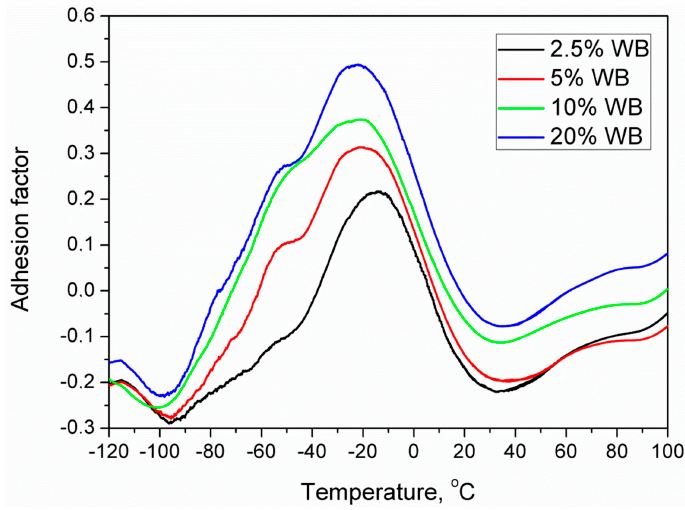
Figure 7. Adhesion factor vs. temperature of rotationally molded PE and PE-WB composites.